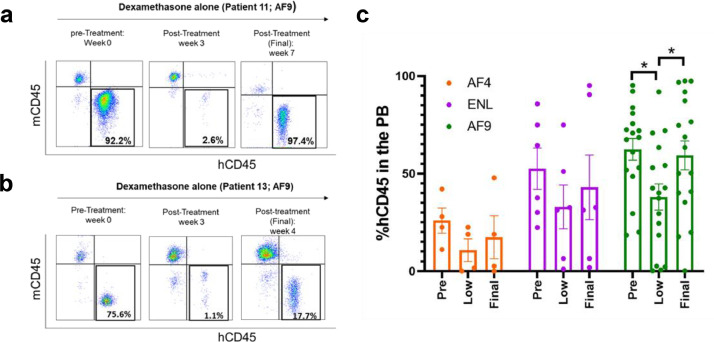
Glucocorticoid resistance of human MLL-rearranged ALL cells.In vivo effect of dexamethasone on hCD45+ MLL-ALL cells in the PB of recipient mice treated for 4 to 7 weeks with 30mg/kg dexamethasone once per day. Recipients engrafted with MLL-ALL cells were prepared from three different MLL-AF4 patients, three MLL-ENL patients, and five MLL-AF9 patients (see Table S1). AF4 recipients: n=4 (Pt.1 n=1, Pt. 2 n=2, Pt. 4 n=1); ENL recipients n=6 (Pt. 6 n=3, Pt. 7 n=1, Pt. 8 n=2); AF9 recipients n=17 (Pt. 10 n=3, Pt. 11 n=4, Pt. 12 n=4, Pt. 13 n=5, Pt. 14 n=1). (a and b) Flow cytometry plots showing percentages of human and mouse CD45+ cells in PB from AF9 Patients (a) 11 and (b) 13 during dexamethasone treatment period. (c) PB chimerism of human MLL-ALL cells at the start of treatment, at lowest hCD45+ chimerism reached during treatment and at the end of treatment in MLL-ALL recipients. Results are expressed as ± 1 standard error of the mean with *P<0.05 by two-tailed T-test.